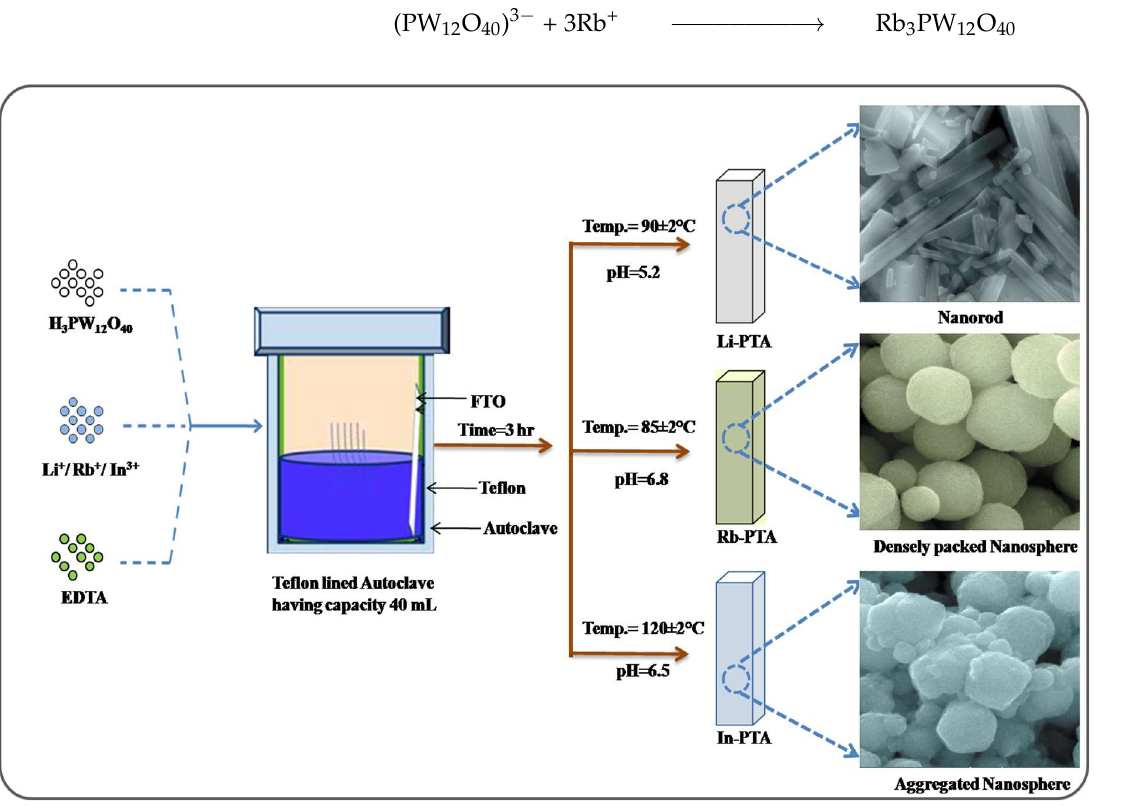
Figure 1. Graphical representation of possible growth mechanism of (i) Li 3 PW 12 O 40 , (ii) Rb 3 PW 12 O 40 , and (iii) In 3 PW 12 O 40 thin film deposited by the single-step hydrothermal approach.